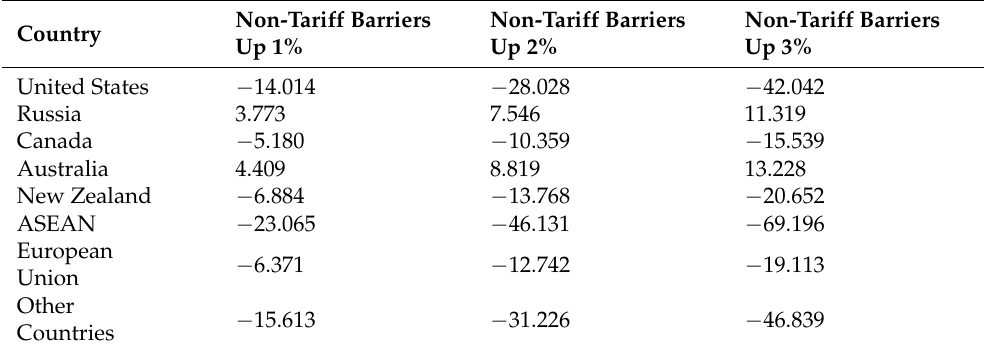
Table 11. Impact of changes in non-tariff barriers on imports from major source countries of agricul- tural